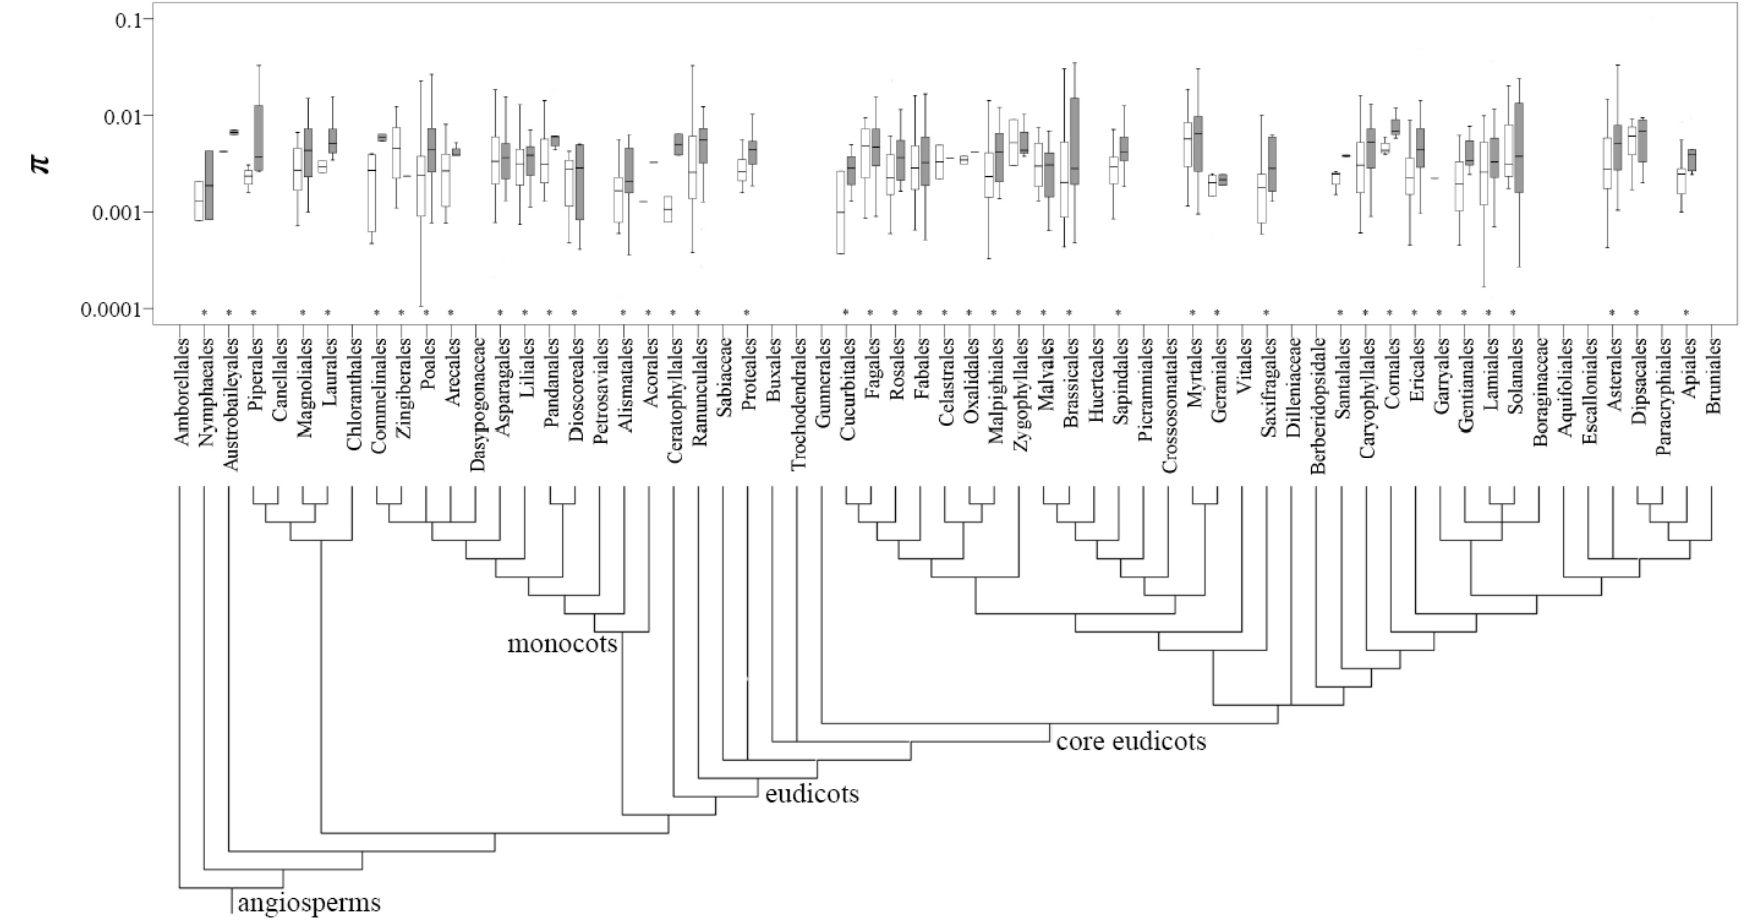
Figure 3. Distribution of the π values at the population (open box) and species (filled box) levels across the angiosperm plants grouped by the orders listed in APG III (2009) (noted with